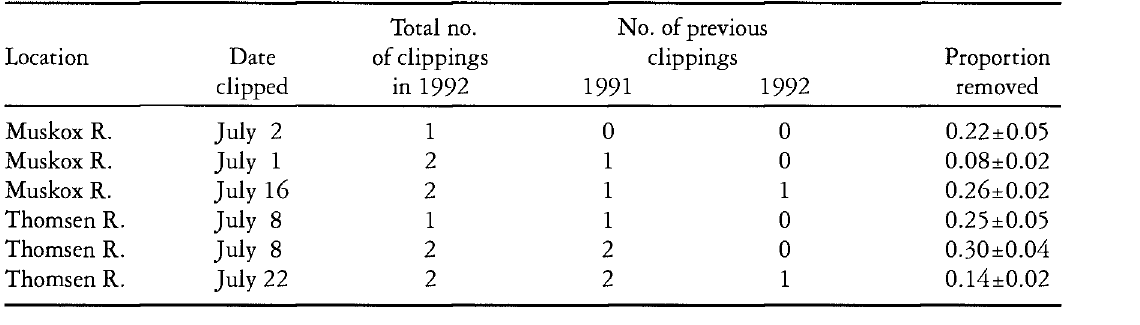
Table 3. Standing crop estimates (g/m 2 ) (mean+SE) (»=5 per treatment) obtained in 1992 and 1993 for plots with vari able clipping histories inside permanent exclosures in 1992 and 1993, northern Banks Island, Canada.